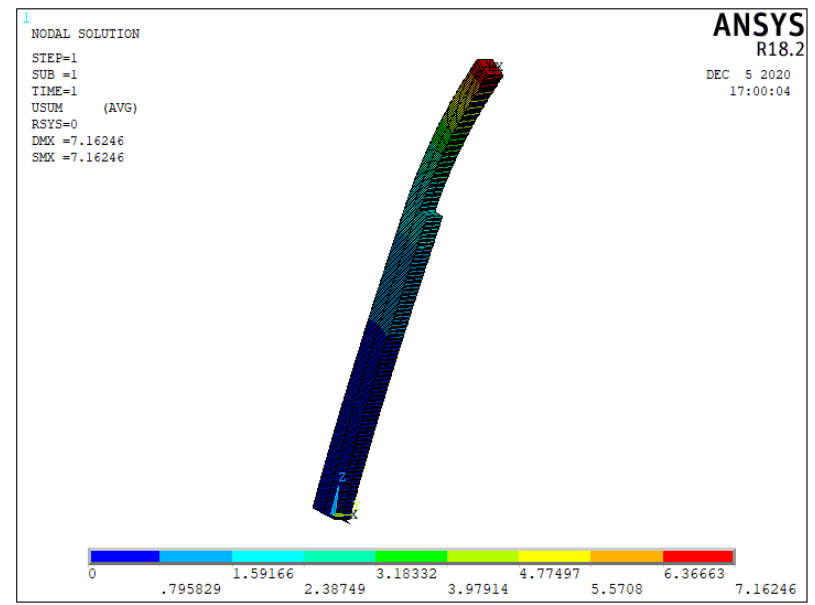
Figure 11. Total displacement of reinforced concrete column.